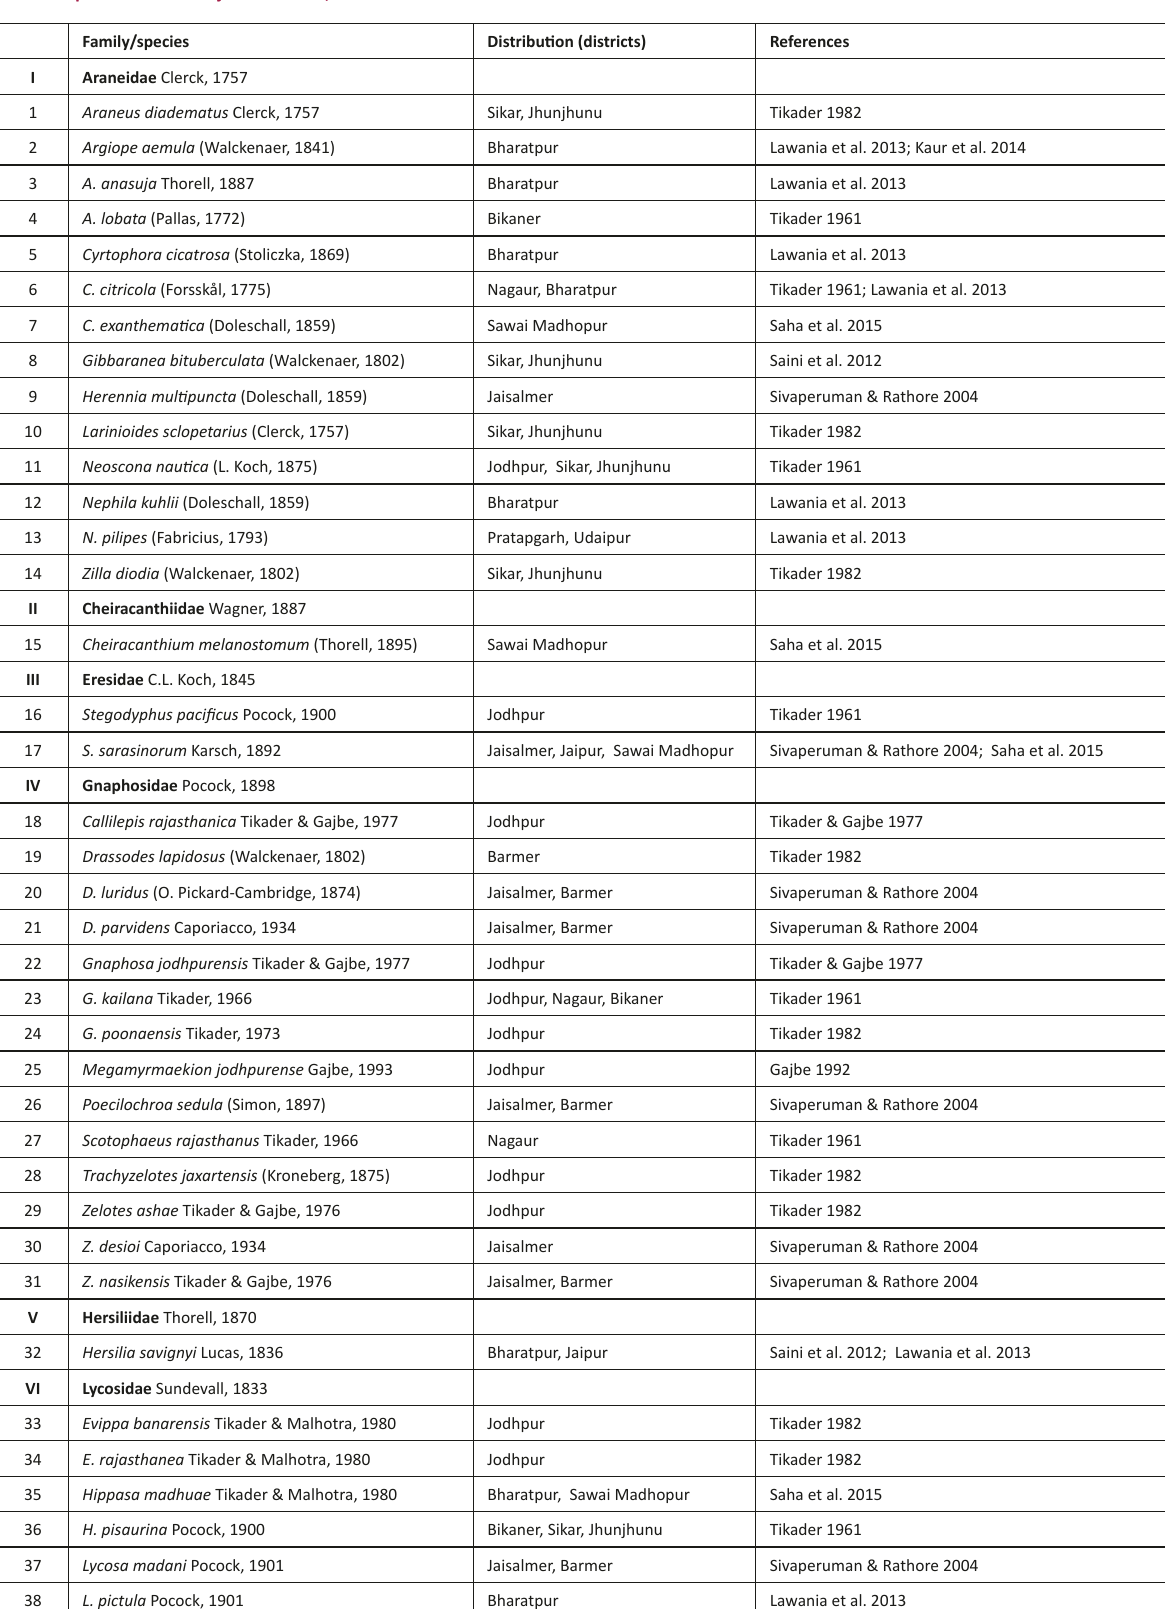
Table 1. Spider fauna of Rajasthan State,